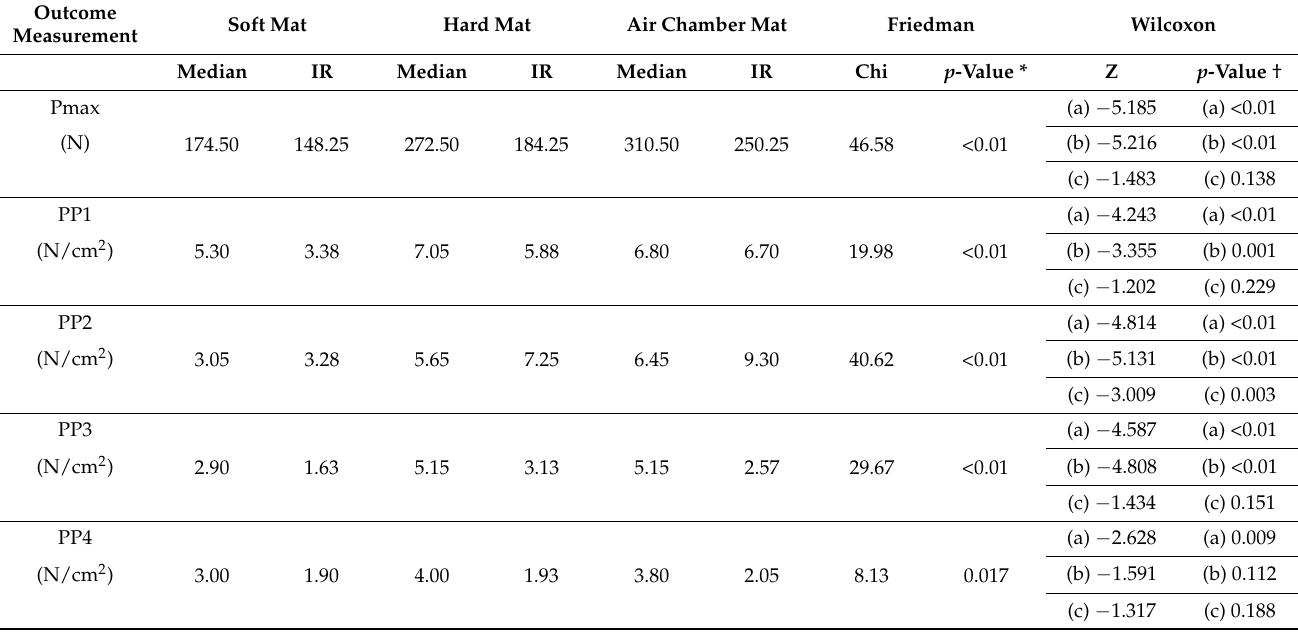
Table 1. Comparison of in-shoe maximum forces and peak plantar pressures for different foot regions (Figure 1D) in mats with different hardness (hard, soft and air chamber) during